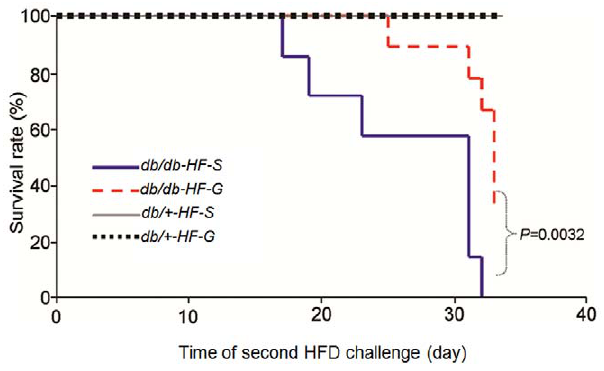
Figure 3. Effect of 17-DMAG on survival rate of HFD-fed db/db mice. Kaplan-Meyer survival analysis was performed using the log-rank statistics to measure the difference between the survival curves of d b/ db-HF-S vs db/db-HF-G mice with n=9 per group. Parallel experiments were performed with db/ + mice ( db/ + -HF-S and db/ + -HF-G groups) and no mortality was observed.